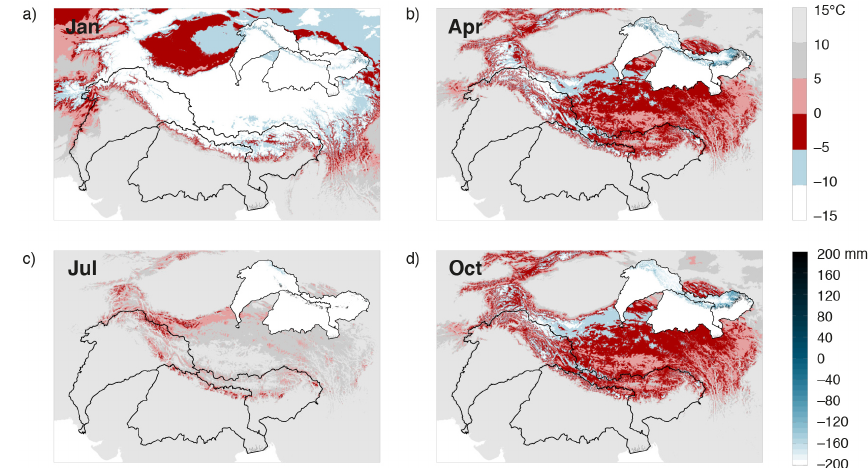
Figure 7. Regions where increasing temperatures are likely to cause a shift from snow to rain. Data are monthly mean MERRA temperature, terrain adjusted to a 4km GLOBE grid. Red indicates temperature between − 5 and 0 ◦ considered critical. Small inset maps show monthly MERRA precipitation in the critical